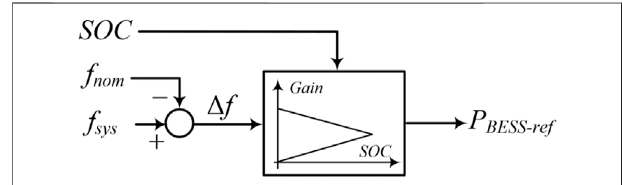
FIGURE 5 | Control concept of the proposed frequency regulation scheme of the